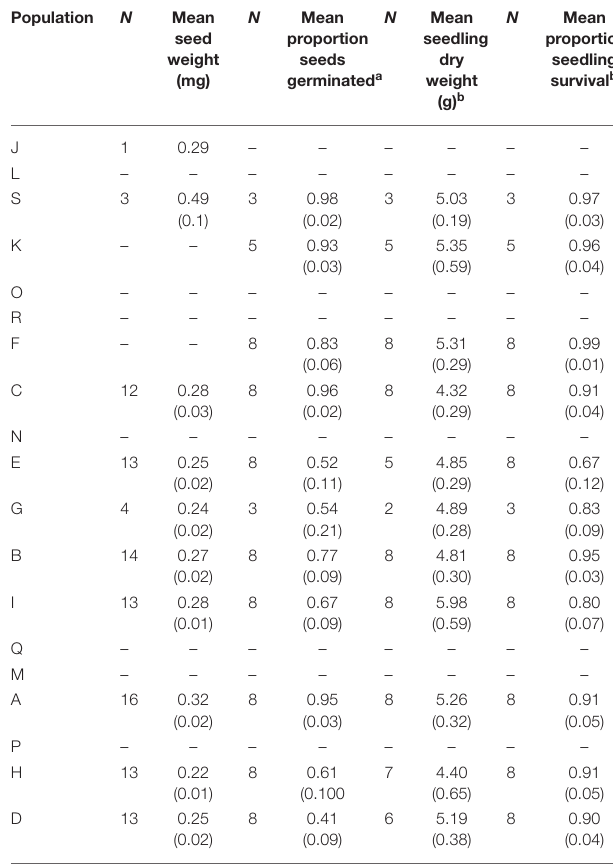
TABLE 8 | Progeny performance measures for seeds collected from 11 Eucalyptus wandoo